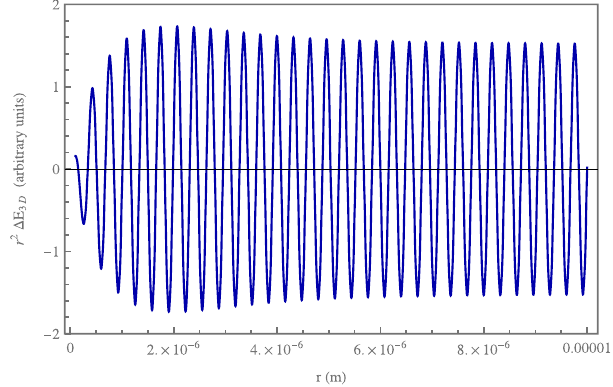
Figure 3. Plot of r 2 Δ E 3 D in arbitrary units for distances of the atoms between 10 − 7 m and 10 − 5 m obtained by a numerical integration using the exact dispersion relation of the photonic crystal and the same parameters of Fig. 2. The figure clearly shows that, after the transition region between the near and far zone at ∼ ⋅ − r 5 10 m 6 , the function r 2 Δ E 3 D asymptotically settles to a constant value. This confirms that asymptotically the resonance interaction energy Δ E 3 D scales as r − 2